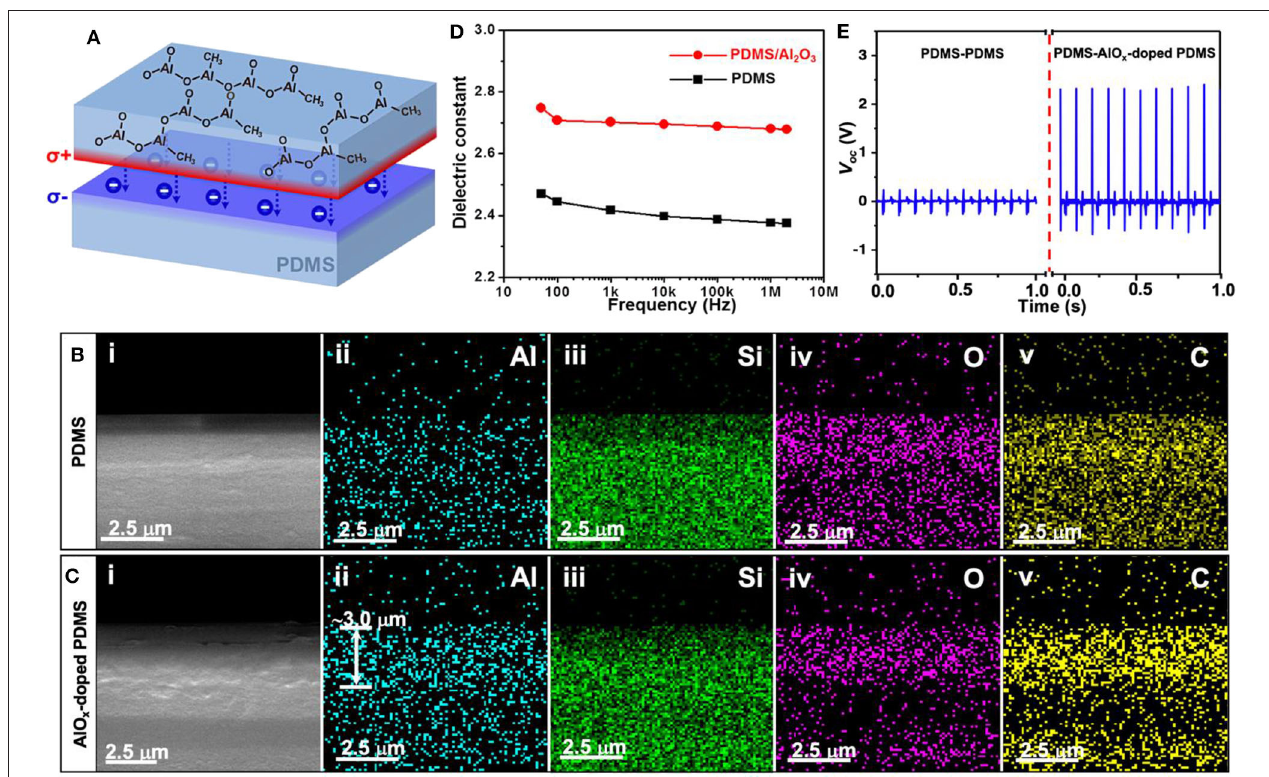
FIGURE 7 | SEM images of SIS-modified triboelectric materials and output performance of as-fabricated TENG. (A) Schematic diagram of triboelectrification induced charge redistribution between pristine PDMS and AlO x -doped PDMS films upon contact. (B,C) Cross-sectional SEM images (i) and corresponding energy dispersive spectroscopy (EDS) mappings of a pristine PDMS film and an AlO x -doped PDMS film for Al, Si, O, and C elements (ii–v). (D) Dielectric constant of pristine PDMS film and AlO x -doped PDMS film. (E) V oc of TENGs based on the PDMS with and without AlO x doping. Reprinted with permission from Yu et al. (2015). Copyright 2015 Wiley-VCH.